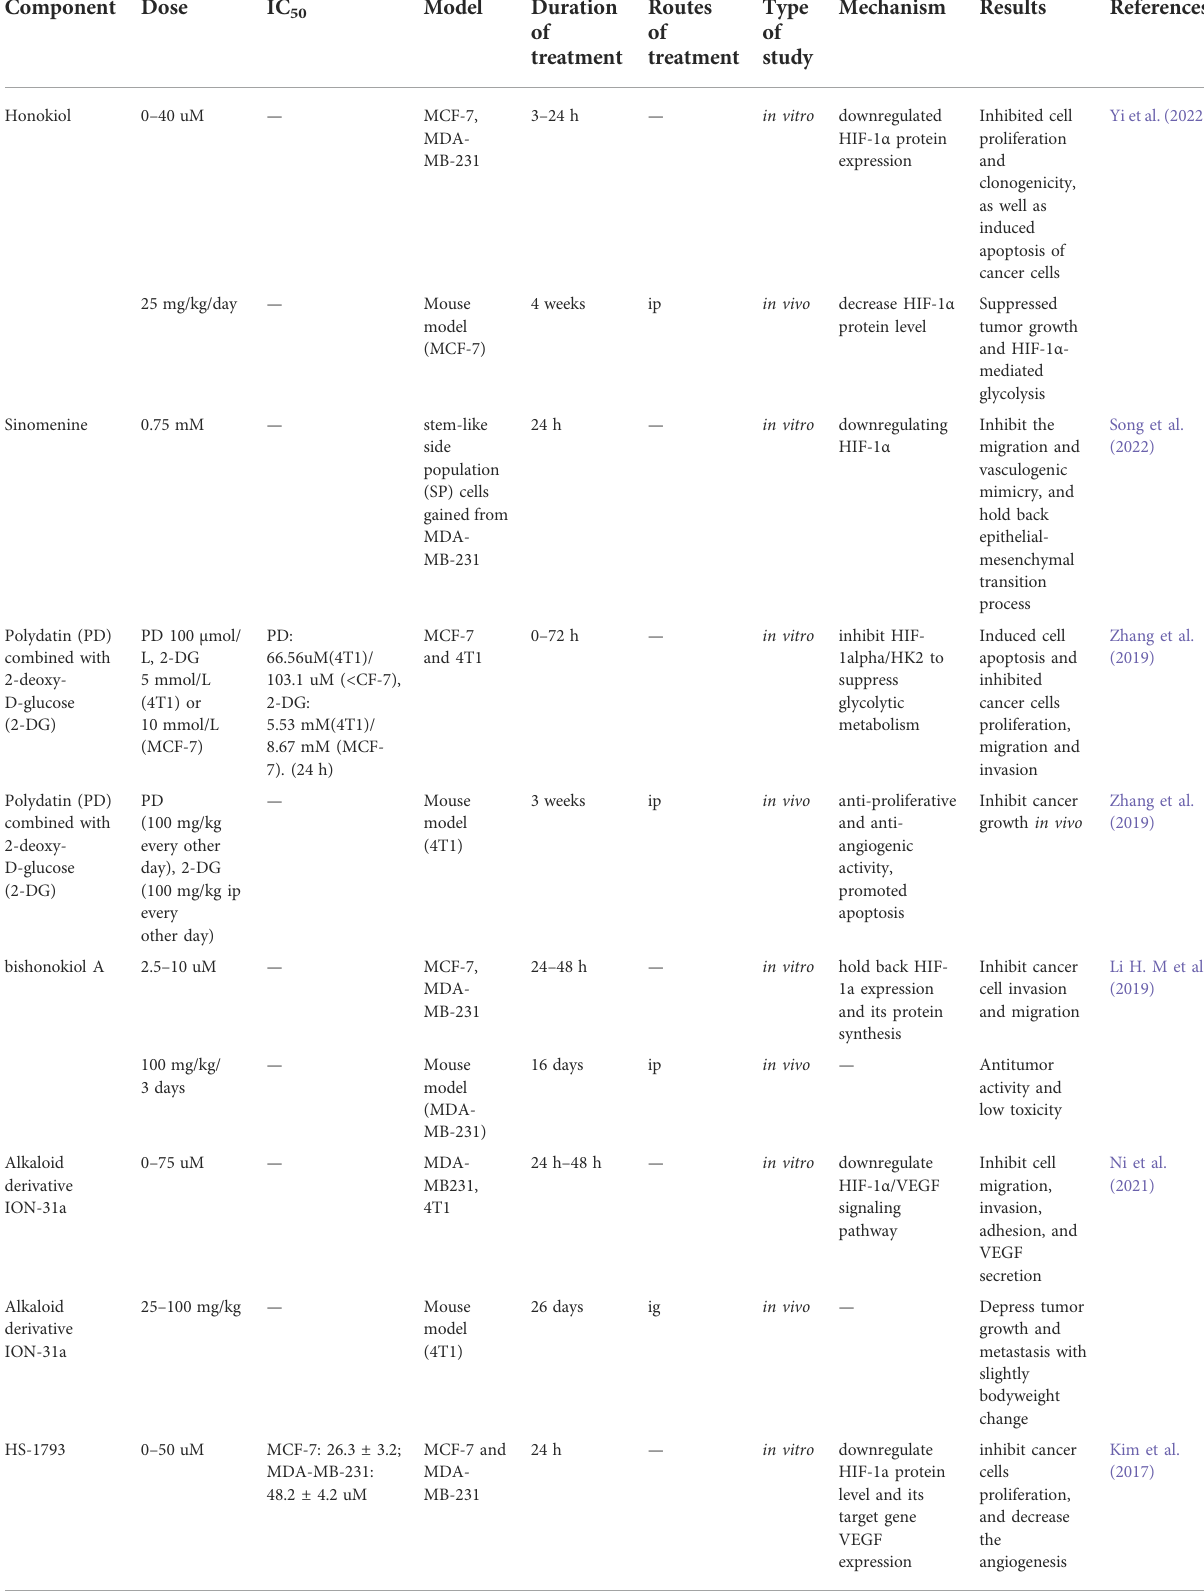
TABLE 3 HIF-1 related signaling pathway inhibitors in